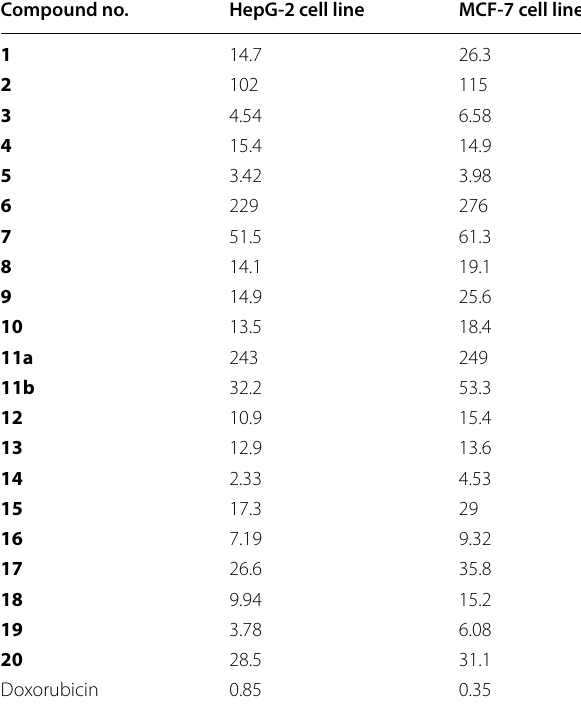
Table 7 IC of the tested compounds against hepatocel- 50 lular carcinoma cell line HePG2 and breast cancer cell line MCF-7 Compound